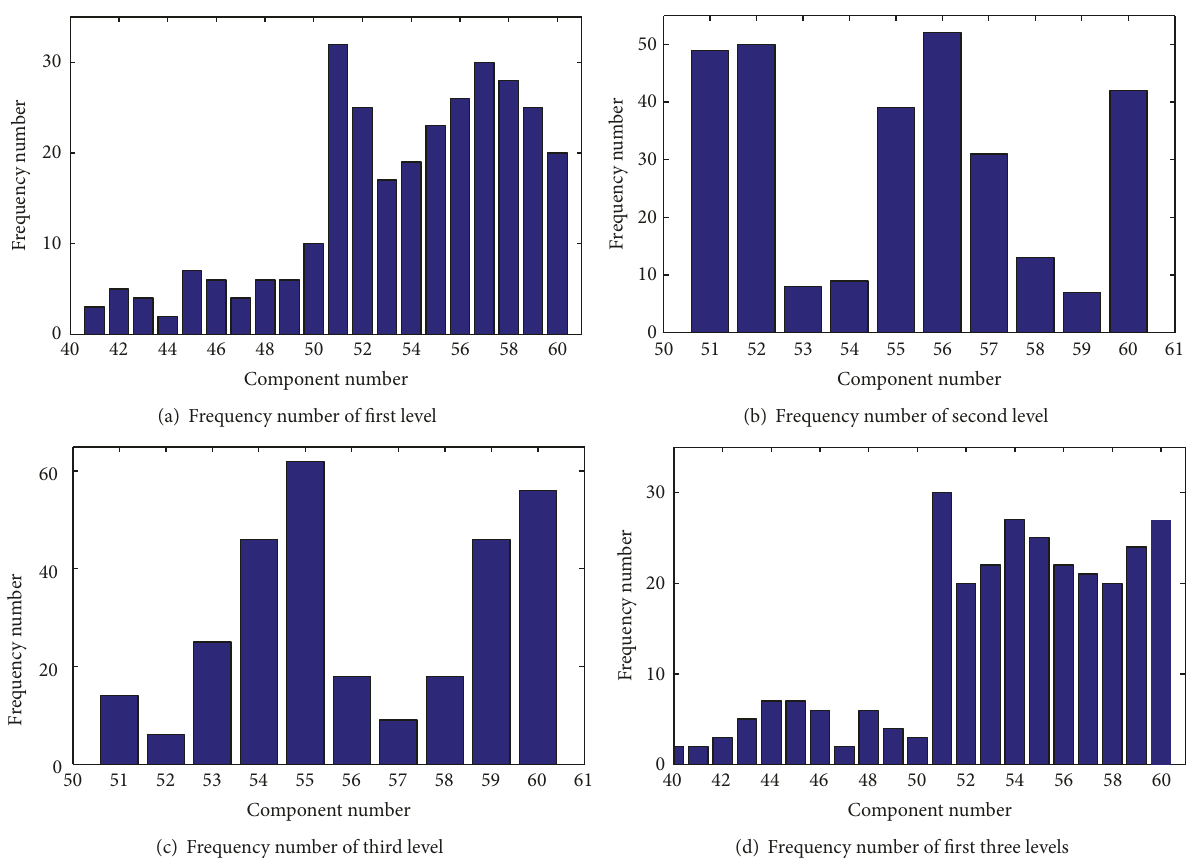
Figure 11: Accumulated frequency of members under various loads.